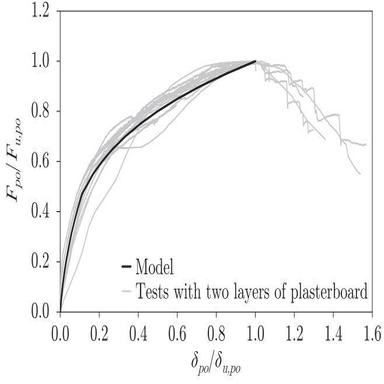
Comparison between the proposed load-slip model and normalised test curves for specimens with two layers of plasterboard.